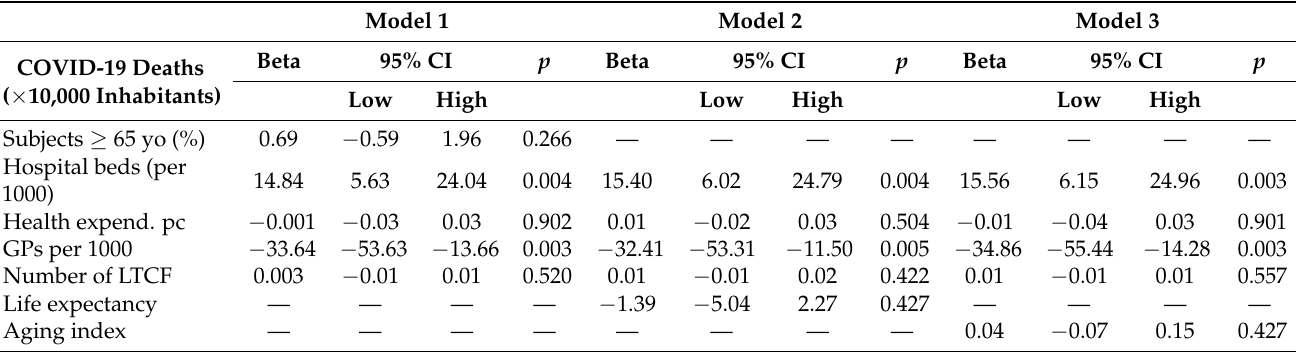
Table 2. Models of multivariate linear regression